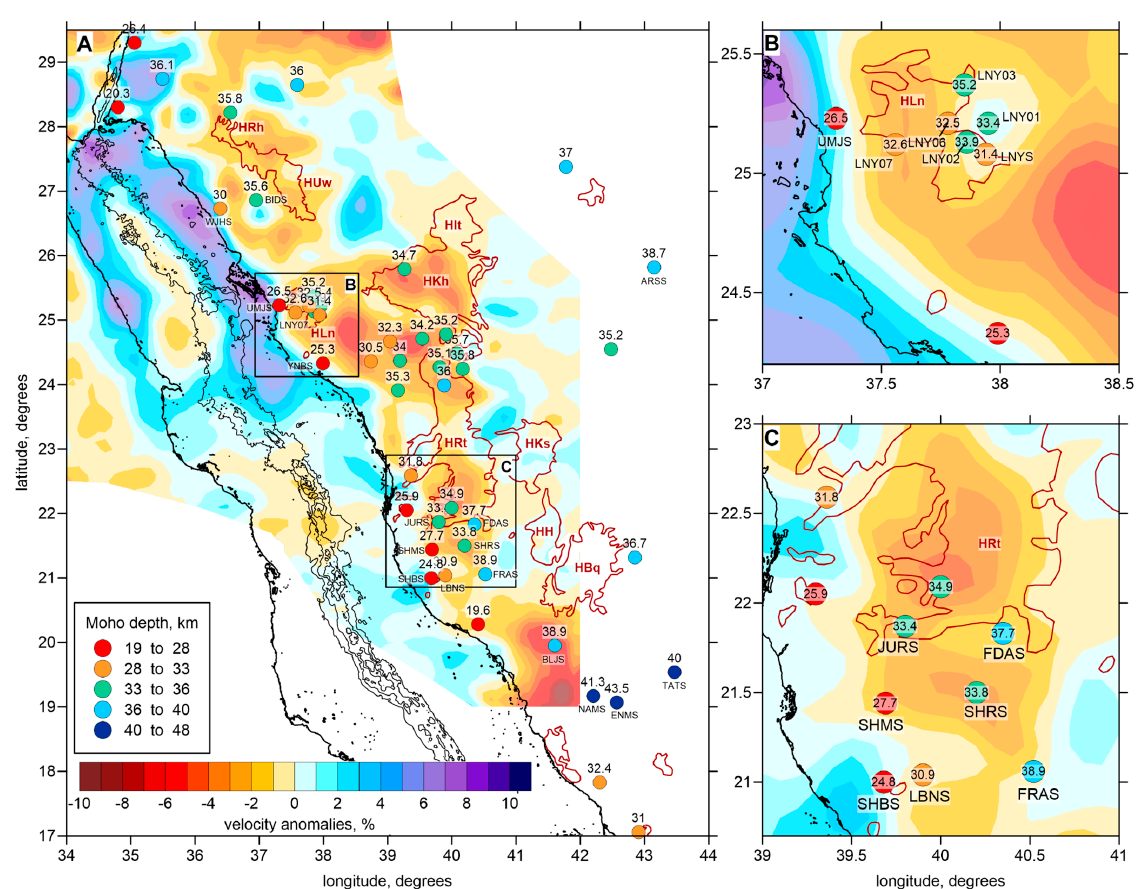
Figure 9. Results of the H-k stacking for the station YNBS located close to the coast of the Red Sea. ( A ): Individual receiver functions (Q-component). The upper trace is the average of all traces. Red, blue, and green hatches mark the theoretical arrivals of the Ps , PpPs and 2p2s phases, respectively. ( B ). The location of the station on the map. ( C – E ): Grid search results for three individual phases Ps , PpPs and 2p2s . ( F ): Result of stacking of the results for all phases. The white dashed lines mark the best solution. The parameters of stacking and results for H and k determination are shown on the panel F.